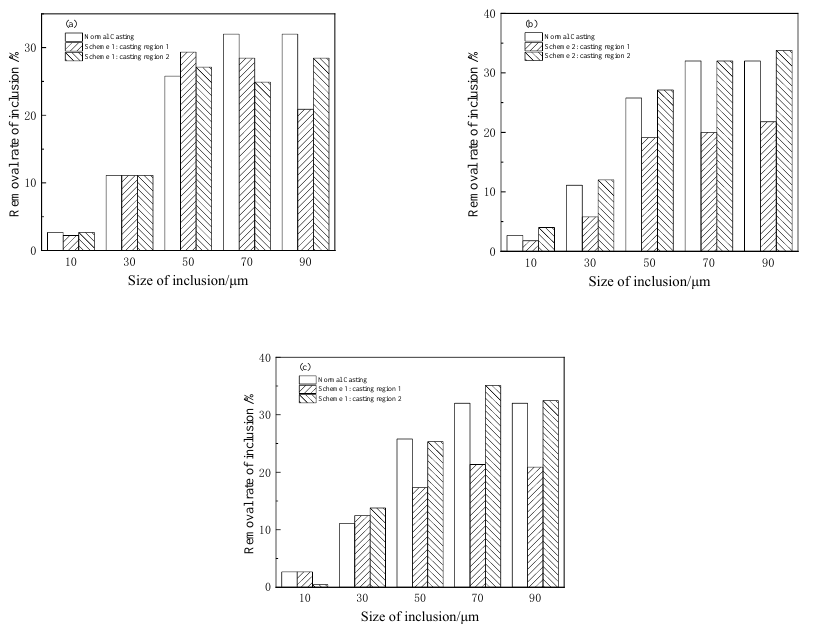
Figure 10. Comparison of inclusion removal rate between casting region 1 and 2 in each scheme: scheme 1 ( a ); scheme 2 ( b ); scheme 3 ( c ).